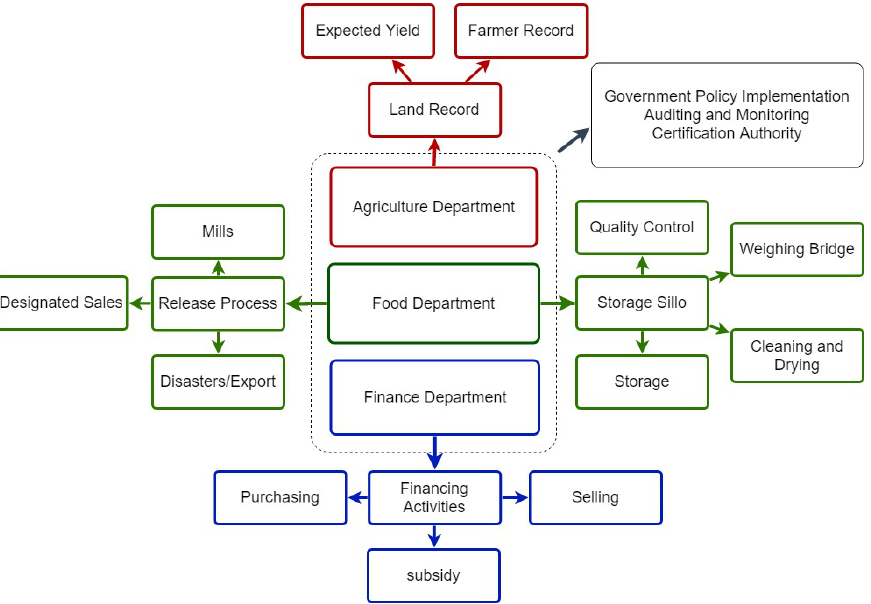
Figure 10. An overview of the proposed